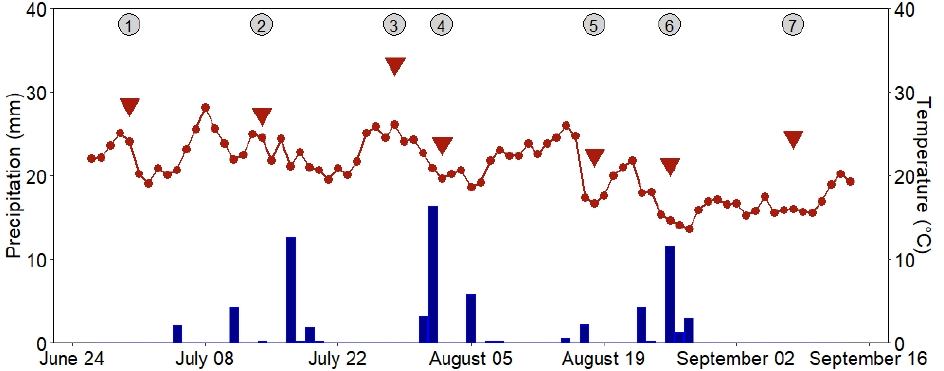
Figure 2. Daily precipitation sums (blue bars, mm), daily average air temperature (red continuous line, °C), and average midday air temperature (red triangles, °C) on measurement days during the study period. Numbers in circle at the top indicate the order of the field measurements.